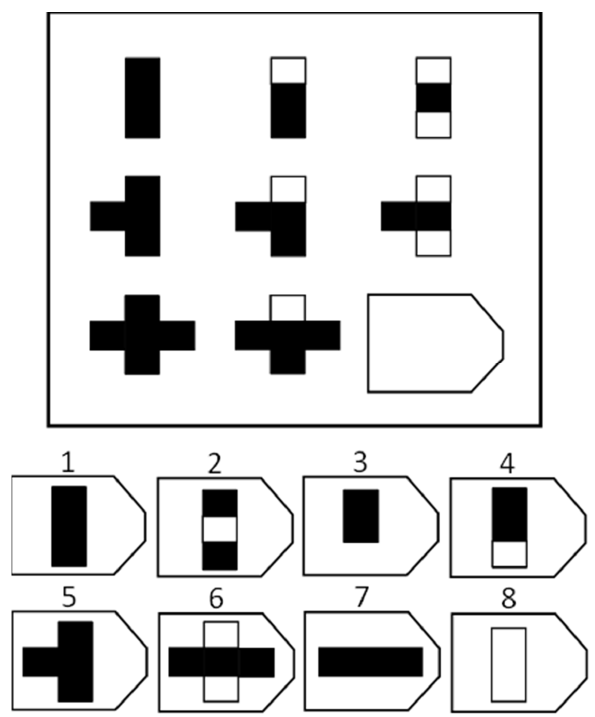
Figure A2. Example item for the Visual Search task. In this example, there are eight faces indicating sadness and one indicating disgust. The top left corner of the top left face was selected, indicating uncertainty towards whether the face displayed the majority emotion or not.